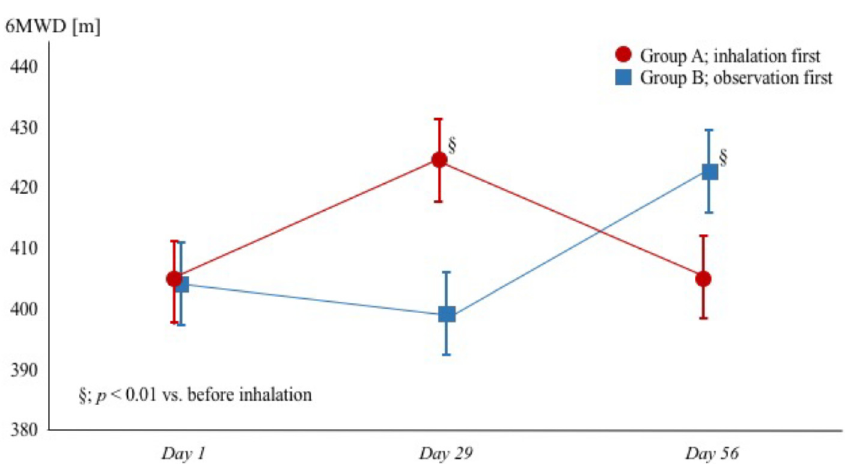
Figure 2. Changes of 6MWD in patients with heart failure with reduced ejection fraction and chronic obstructive pulmonary disease. Red circles ( ● ) and blue squares ( ▪ ) represent group A (tiotropium + observation) and group B (observation + tiotropium), respectively. 6MWD = 6-min walk distance.